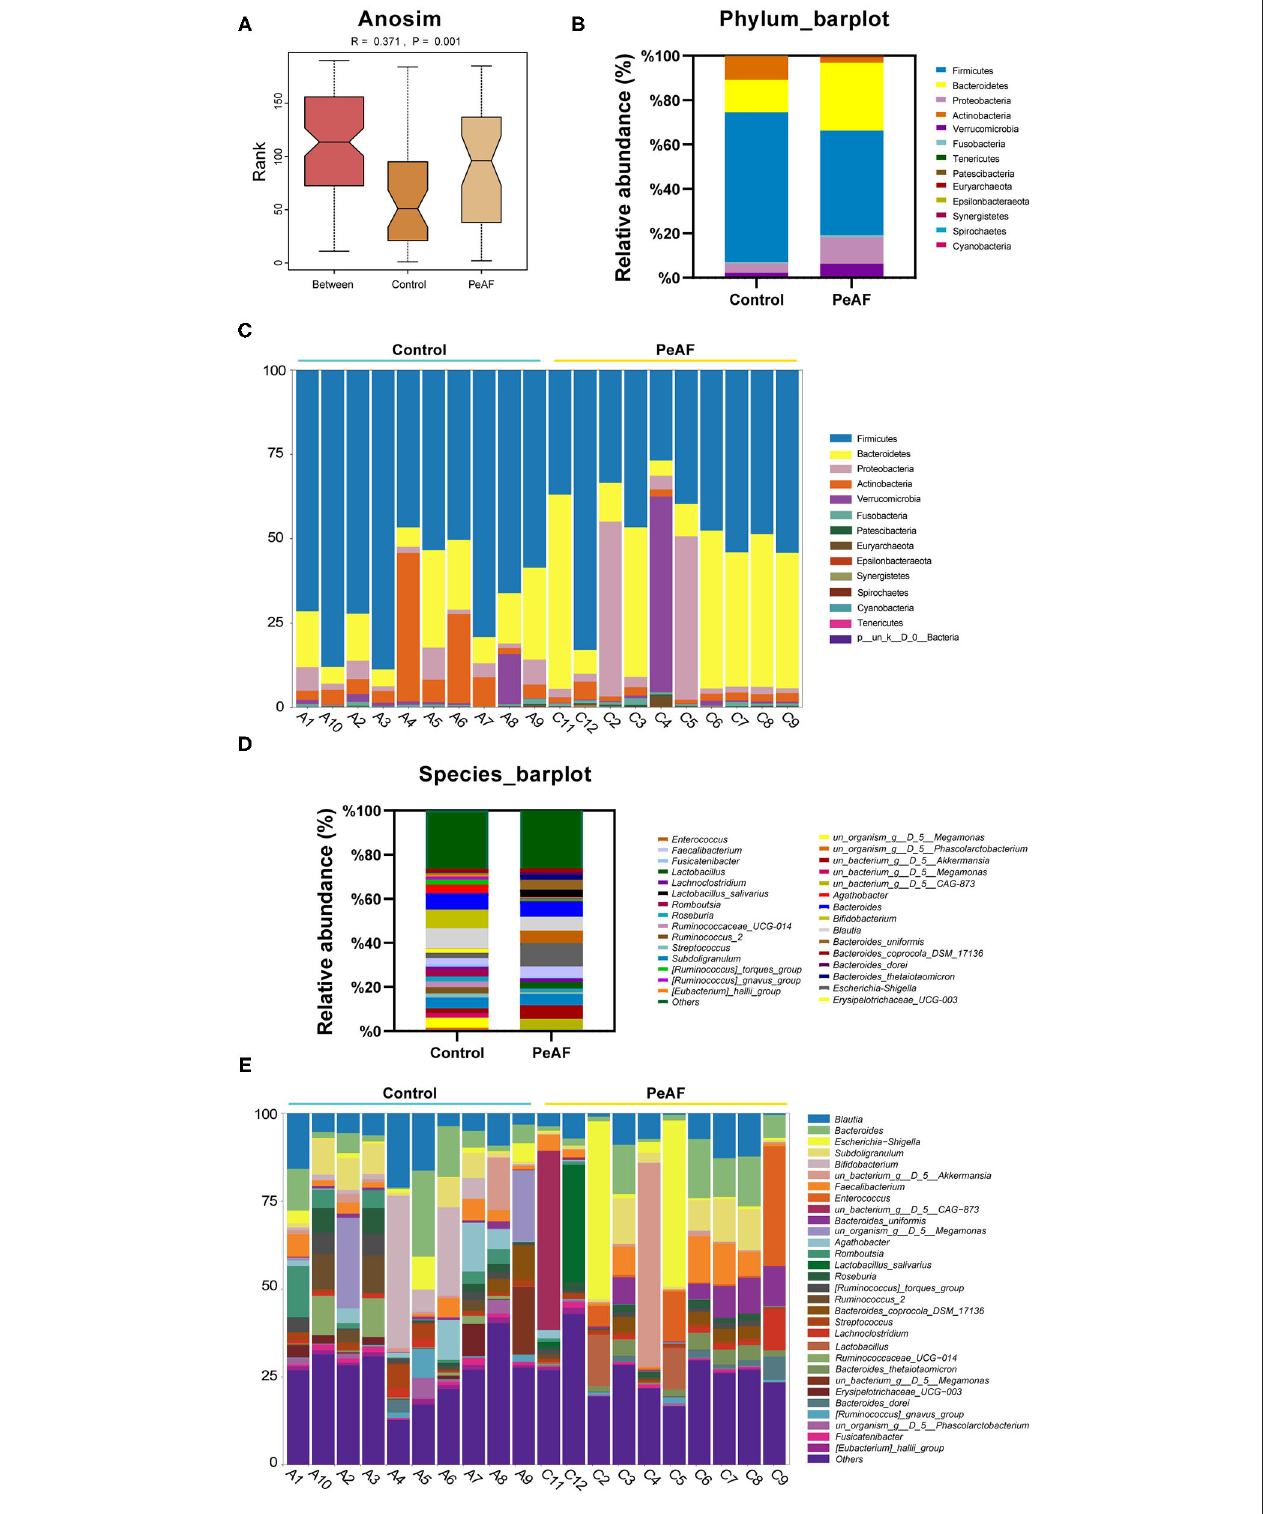
FIGURE 3 | Changes in the intestinal microbial community structure. (A) Anosim analysis; p < 0.05 was regarded as statistically significant. (B,C) . Histogram of the relative abundances in the intestinal flora of different populations at the phylum level. (D,E) Species-level analysis of the relative abundances in the intestinal flora of different